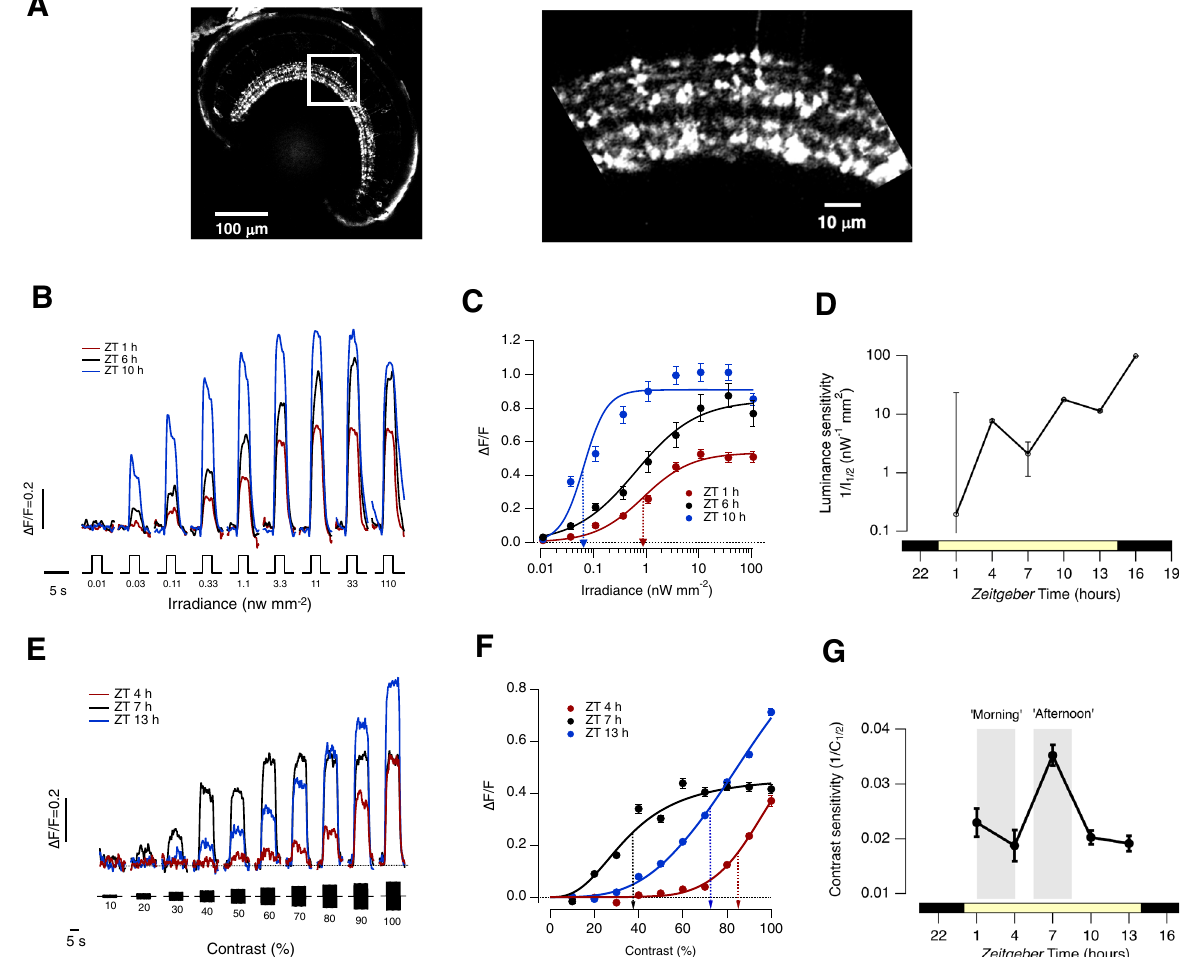
Fig. 1 Differential regulation of luminance sensitivity and contrast sensitivity. A Left: Retina of a Ribeye:SyGCaMP2 fi sh with box over the inner plexiform layer (IPL). Right: expansion of the boxed region showing terminals of bipolar cells. Zebra fi sh larvae were 7 – 9 days post-fertilization. B Averaged responses from ON terminals to light steps of different irradiance measured at Zeitgeber time 1, 6 and 10 hours. Note large variations in amplitude and kinetics. The full- fi eld light stimuli were generated by an amber LED ( l max = 590 nm) which will most effectively stimulate red and green cones. Each light step lasted 3 s ( n = 535 terminals from 10 fi sh). C Peak response as a function of irradiance for ON terminals in ( B ). The smooth lines are Hill functions of the form R = R max *( I h /( I h + I 1/2 h )), where R is the peak response, I is the irradiance, h is the Hill coef fi cient and I 1/2 is the irradiance generating the half-maximal response. At ZT = 6 h: R max = 0.91 ± 0.04; h = 2.0 ± 0.2; I 1/2 = 0.066 ± 0.02 nW/mm 2 (dashed blue arrow). At ZT = 10 h: R max = 0.85 ± 0.06; h = 0.8 ± 0.1; I 1/2 = 0.65 ± 0.18 nW/mm 2 . At ZT = 1 h: R max = 0.853 ± 0.02; h = 0.9 ± 0.2; I 1/2 = 0.88 ± 0.18 nW/mm 2 (dashed red arrow). D Variations in luminance sensitivity as a function of Zeitgeber time averaged across both ON and OFF terminals ( n = 535 and 335 terminals, respectively). The lower bar shows the timing of the light-dark cycle. Error bars are ± 1 SD. E Averaged responses to stimuli of different contrasts (i.e. sinusoidal modulations in light intensity around a mean) measured at Zeitgeber time 4, 7 and 13 h averaged across both ON and OFF terminals ( n = 949 from 21 fi sh). F Peak response amplitude as a function of contrast for terminals shown in E. The smooth lines are Hill functions used to interpolate values of C 1/2 , the contrast generating the half-maximal response. Note the diurnal variations. At ZT = 4 h: C 1/2 = 86 ± 2% (dashed red arrow); h = 7.0 ± 1.2. At ZT = 7 h: C 1/2 = 35 ± 2% (dashed black arrow); h = 2.7 ± 0.2. At ZT = 13 h: C 1/2 = 72 ± 2%; h = 3.3 ± 0.2 (dashed blue arrow). G Variations in contrast sensitivity as a function of Zeitgeber time averaged across ON and OFF terminals ( n = 949 from 21 fi sh). Note the peak around ZT = 7 h which is not mirrored in the diurnal variation in luminance sensitivity ( D ). The grey bars show the periods described as “ morning ” and “ afternoon ” . All error bars show ± 1 s.e.m. except for ( D ) which is ± 1 SD. Source data are provided as a Source Data fi